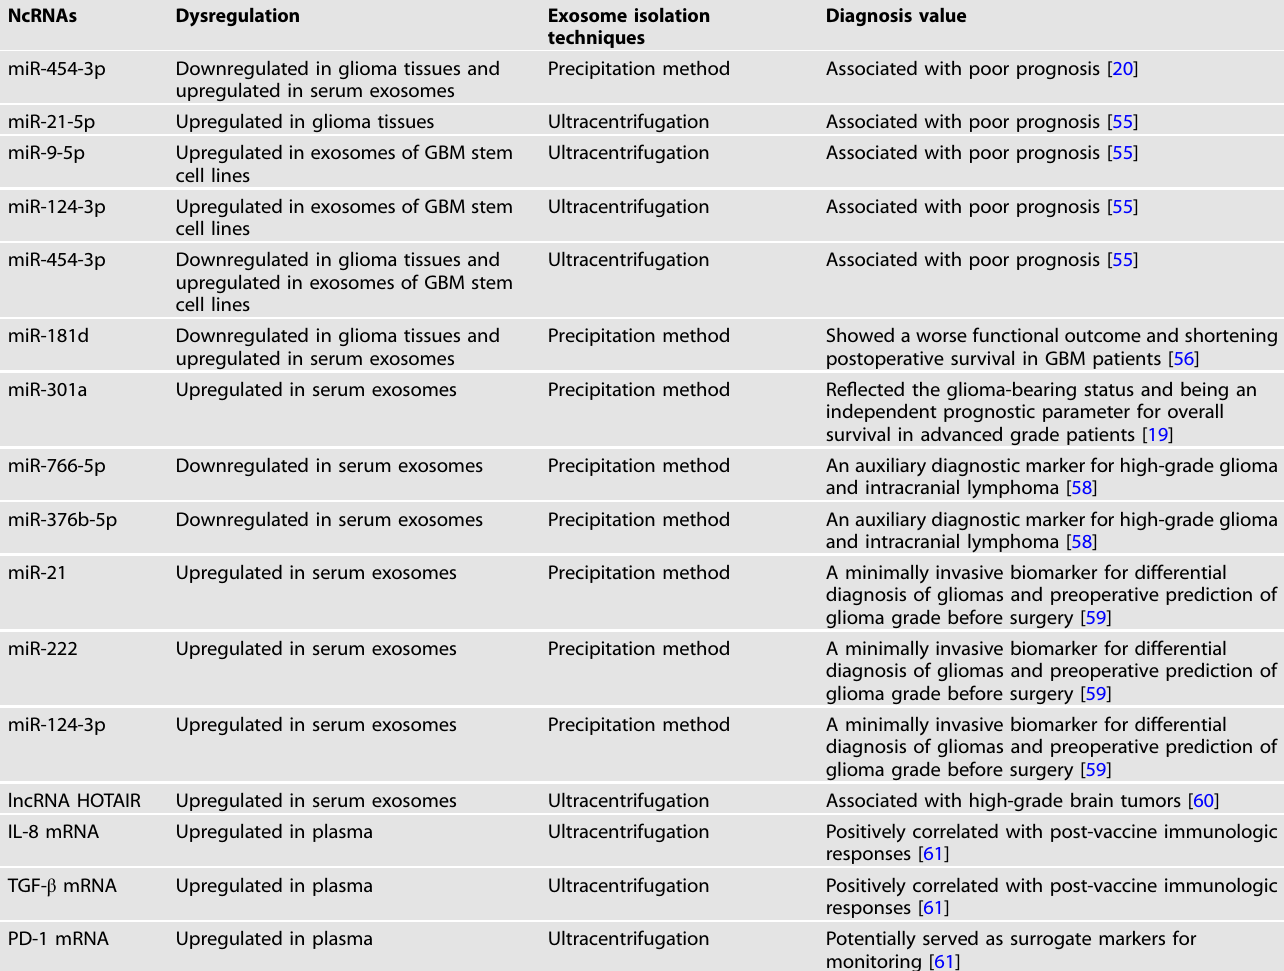
Table 2. The value of tumor-derived exosomal ncRNAs in glioma